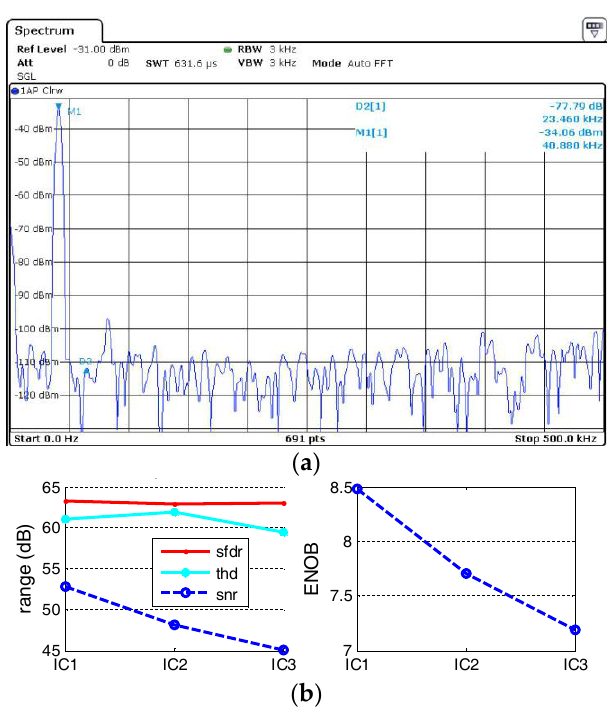
Figure 14. ( a ) The measured spectrum of test group 1, with an input of a 40.88 kHz sine-wave at a clock frequency of 3.125 MHz. ( b ) The measured dynamic performance including spurious-free dynamic range (SFDR), the total harmonic distortion (THD), the signal-to-noise ratio (SNR), and the effective number of bits (ENOB) of test groups 1–3 under the identical test environment, as in Figure 11a.